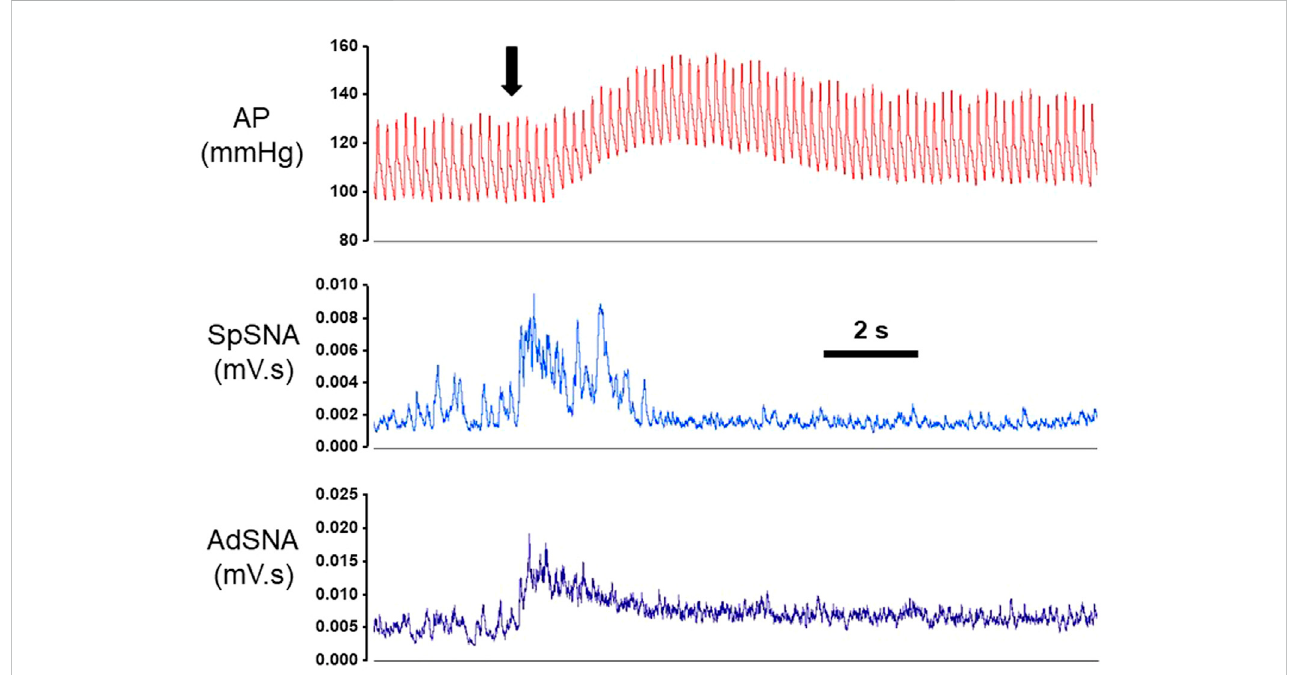
FIGURE 1 Examples of beat-by-beat blood pressure (AP), splanchnic sympathetic nerve (SpSNA) and adrenal sympathetic nerve (AdSNA) recordings in one animal during a single microinjection of glutamate into the rostral ventrolateral medulla (RVLM). Following microinjection of glutamate (100 mM, 30 nL; denoted by arrow) in the RVLM, SpSNA, and AdSNA increased almost immediately and preceded subsequent increases in AP. Abbreviations: mV · s; millivolt-seconds of integrated SNA. Scale bar represents 2 s.